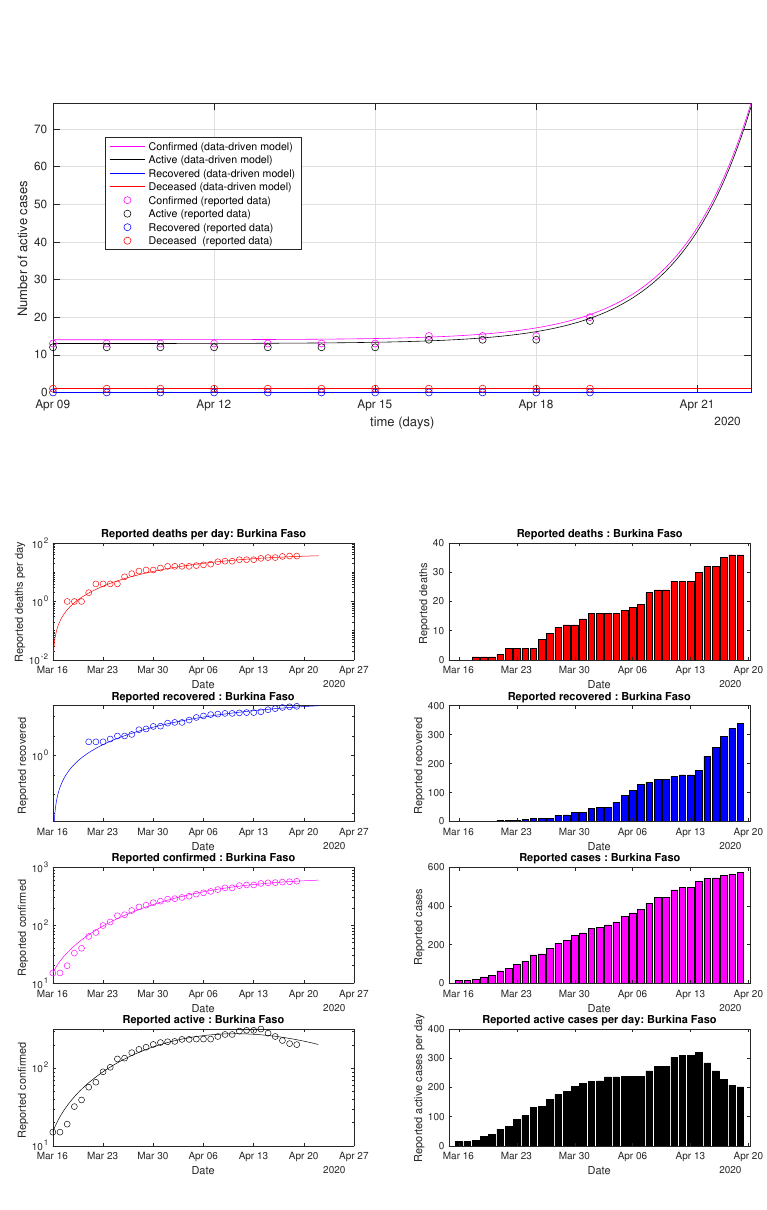
Figure 52. Botswana: data of active, recovered, deceased (in circle or bar) vs. model of active, recovered, deceased over time. Tracking the number of active cases. Predictive analytics for the next couple